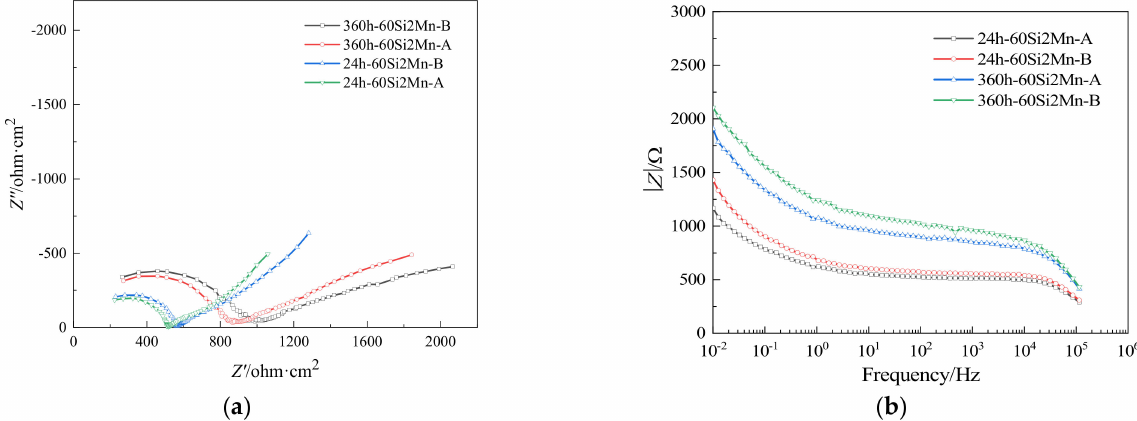
Figure 8. The Nyquist curve and Bode curve of the rusty samples at different corrosion time: ( a ) Nyquist plots; ( b ) Bode plots.